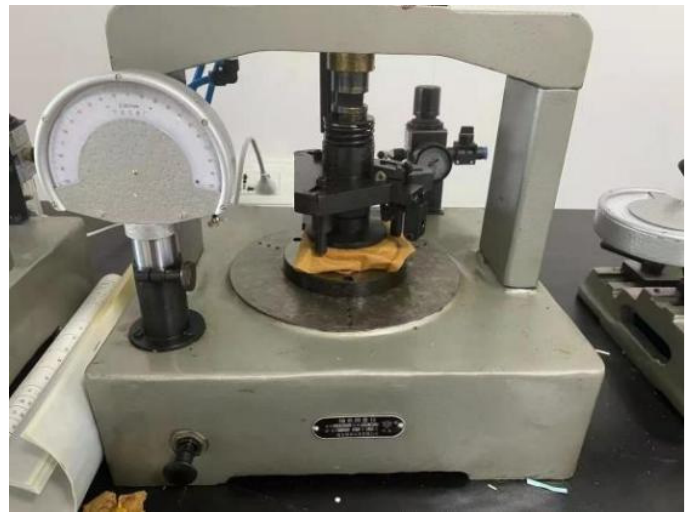
Figure 2. Stickout measuring instrument of angular contact ball bearing.